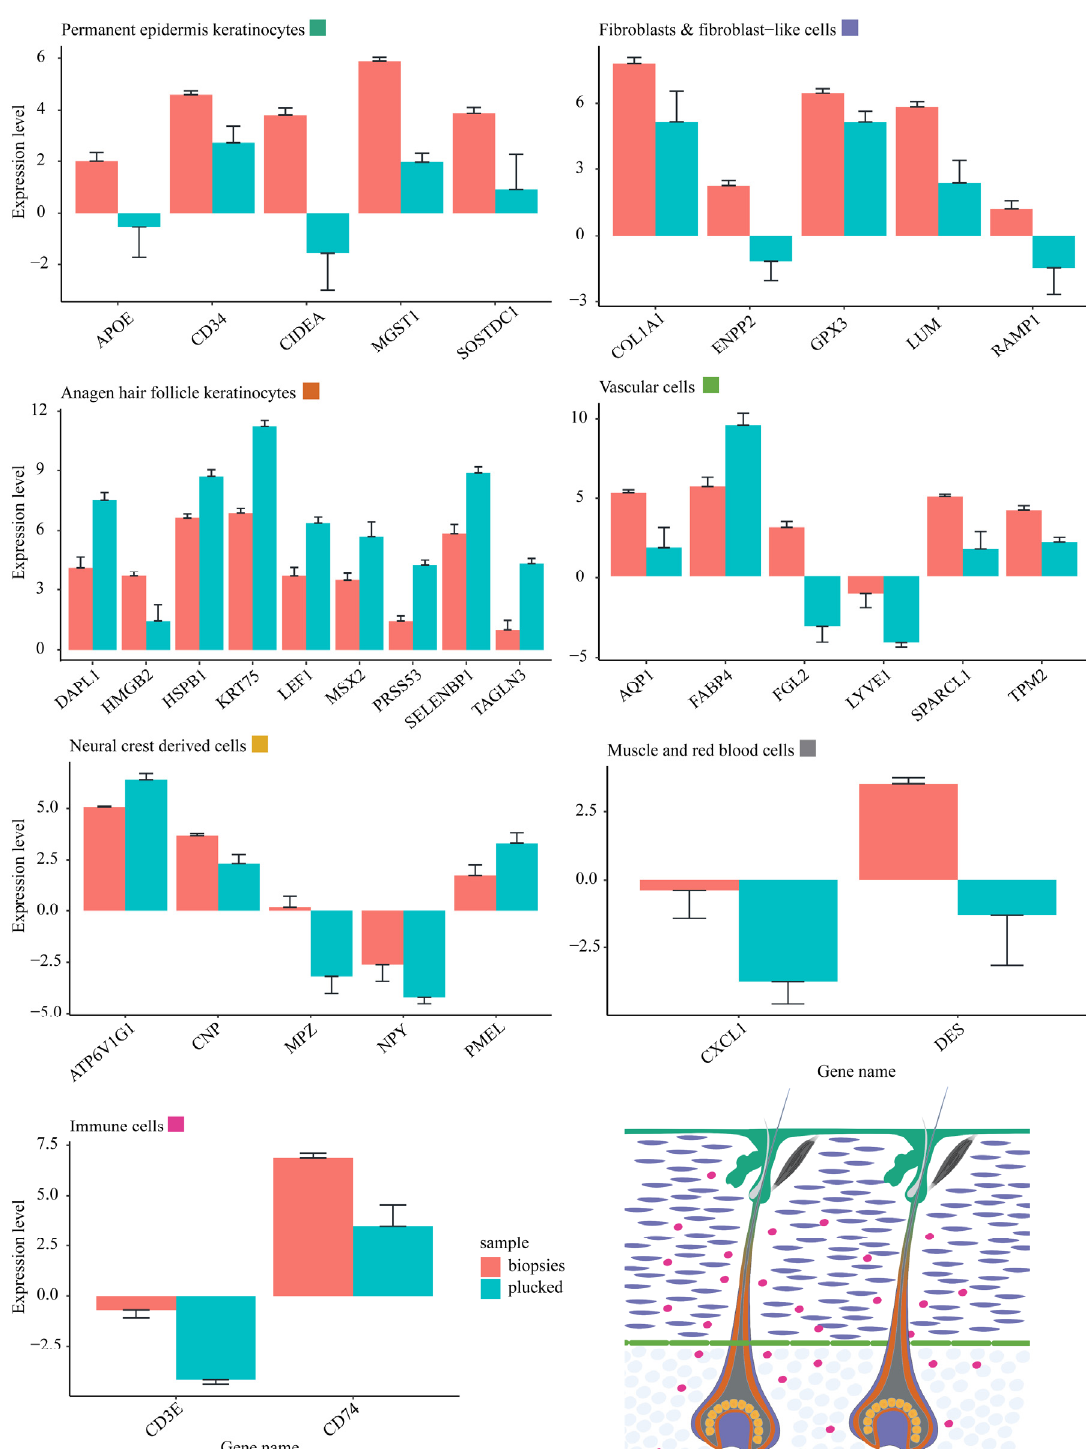
Figure 4. Expression of marker genes for particular populations of cells present in the skin. Only differentially expressed genes between plucked hair and skin biopsies were considered. Each cell population is assigned a distinct color represented in the rectangles adjacent to the cell population name. The spatial localization of these distinct cell populations is illustrated in the longitudinal skin